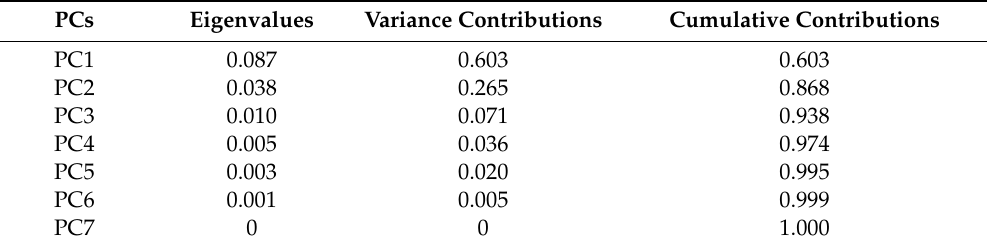
Table 5. The characteristics of eigenvalues and PCs.